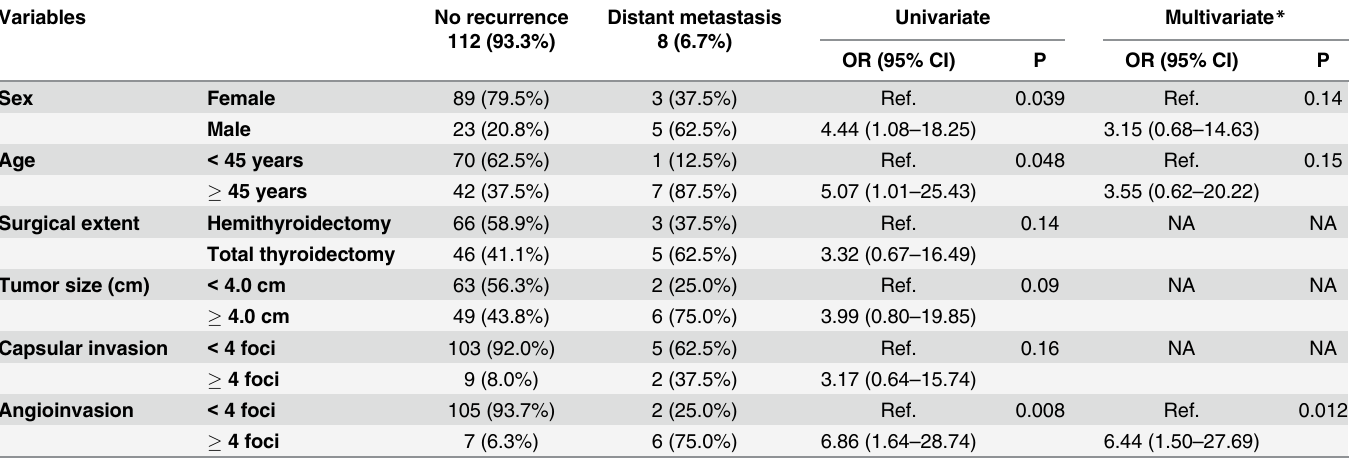
Table 3. Univariate and multivariate analysis of risk factors for distant metastasis. Variables